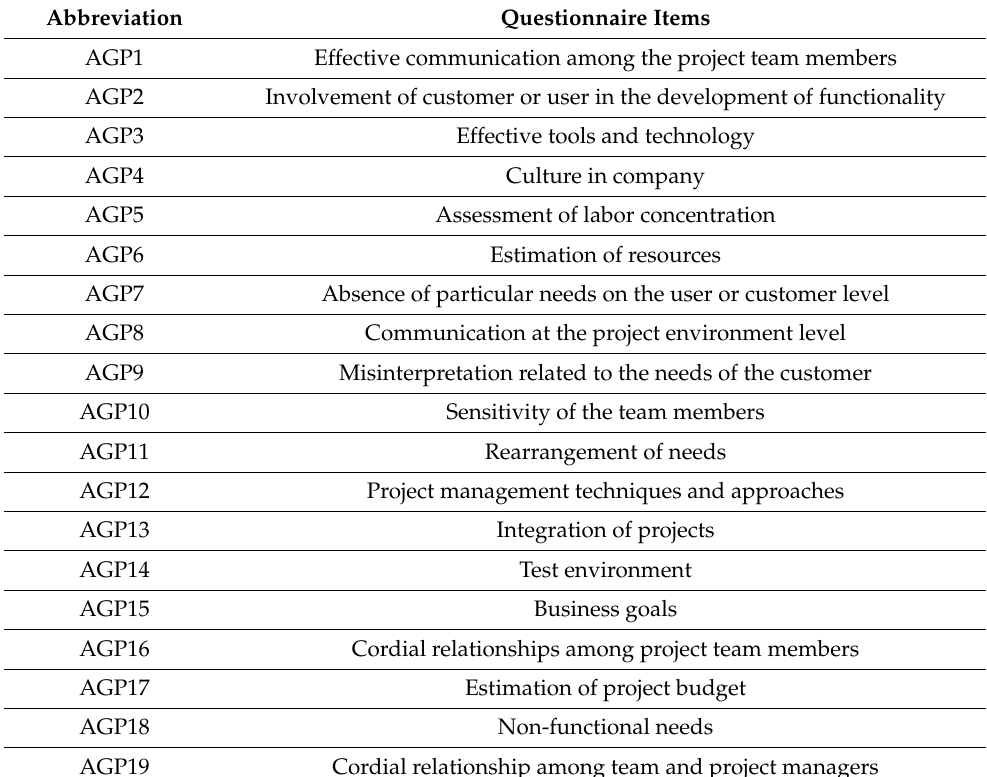
Table 1. Measurement items (Trzeciak